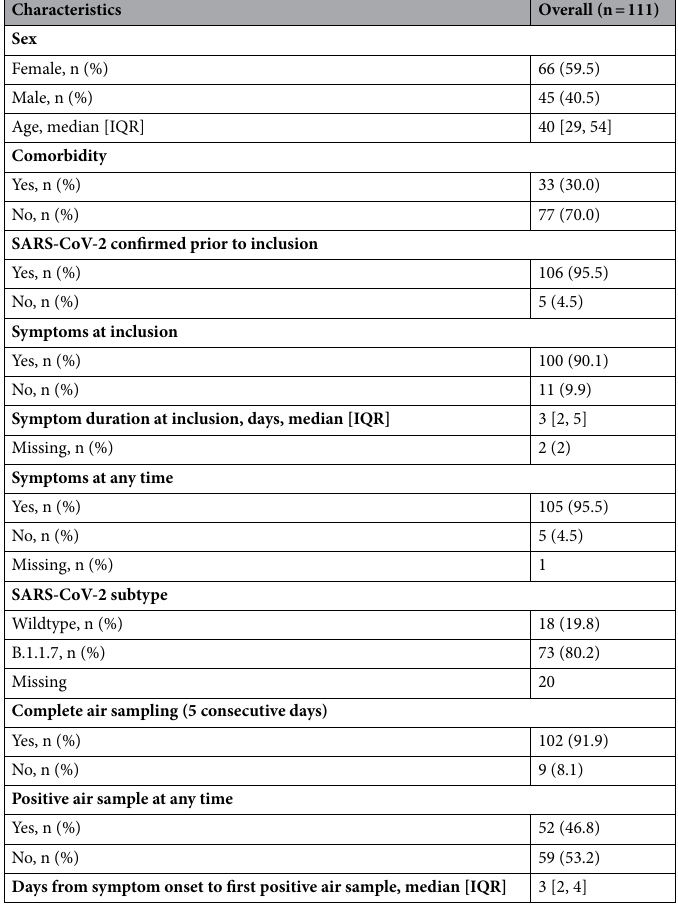
Table 1. Characteristics of subjects with confirmed SARS-CoV-2 infection. n number, IQR interquartile range, SARS-CoV-2 severe acute respiratory coronavirus 2.